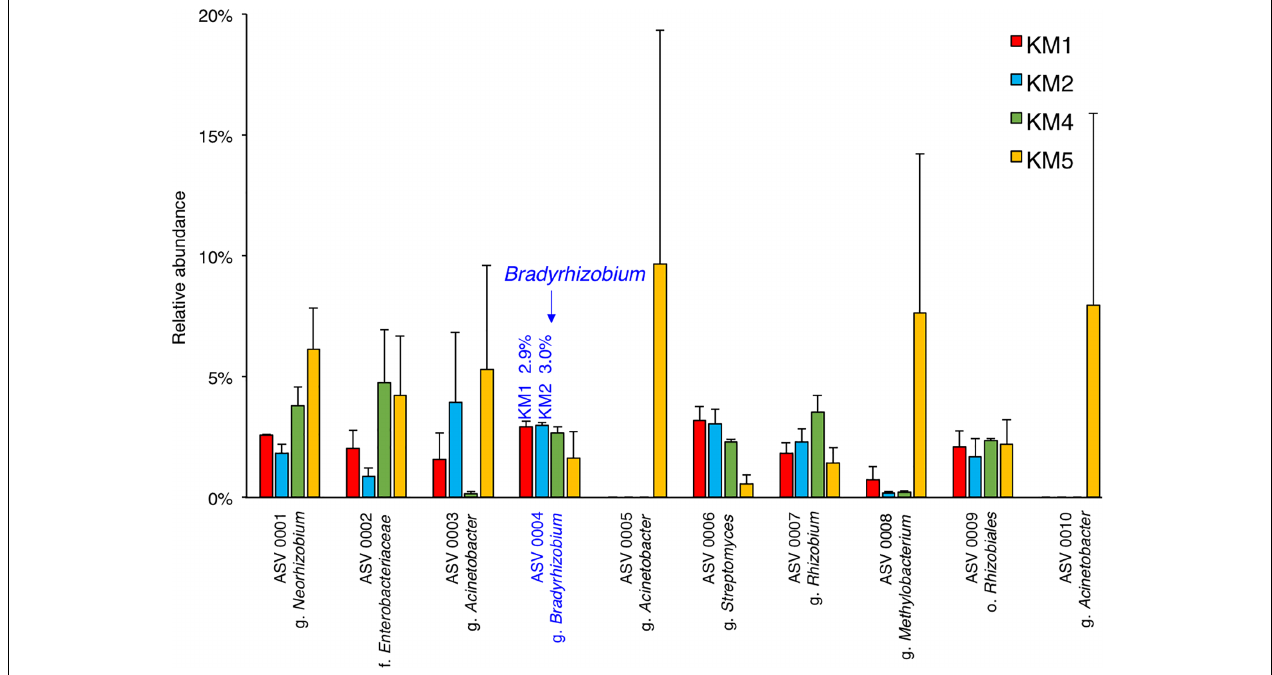
FIGURE 3 | Relative abundance of ten most abundant ASV (amplicon sequence variants) in sorghum lines KM1, KM2, KM4, and KM5 by amplicon analysis of 16S rRNA genes. The ASVs were identified at the lowest possible classification, where o. is order, f. is family and g. is genus. Bar indicates standard error of three biological